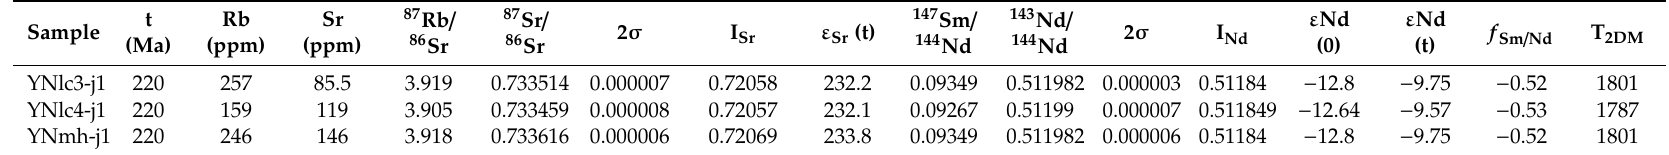
Table 4. Sr-Nd isotope ratios of the QN and MH